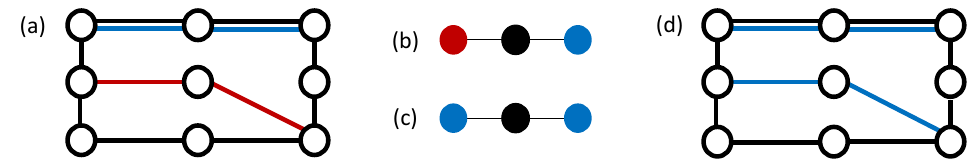
Figure 4. ( a ) A graph G ∗ using k = 3 colours; ( b ) the underlying conflicts graph (and 3-colouring) prescribed by G ∗ ; ( c ) a 2-colouring of this conflicts graph; and ( d ) the original graph G ∗ using k = 2